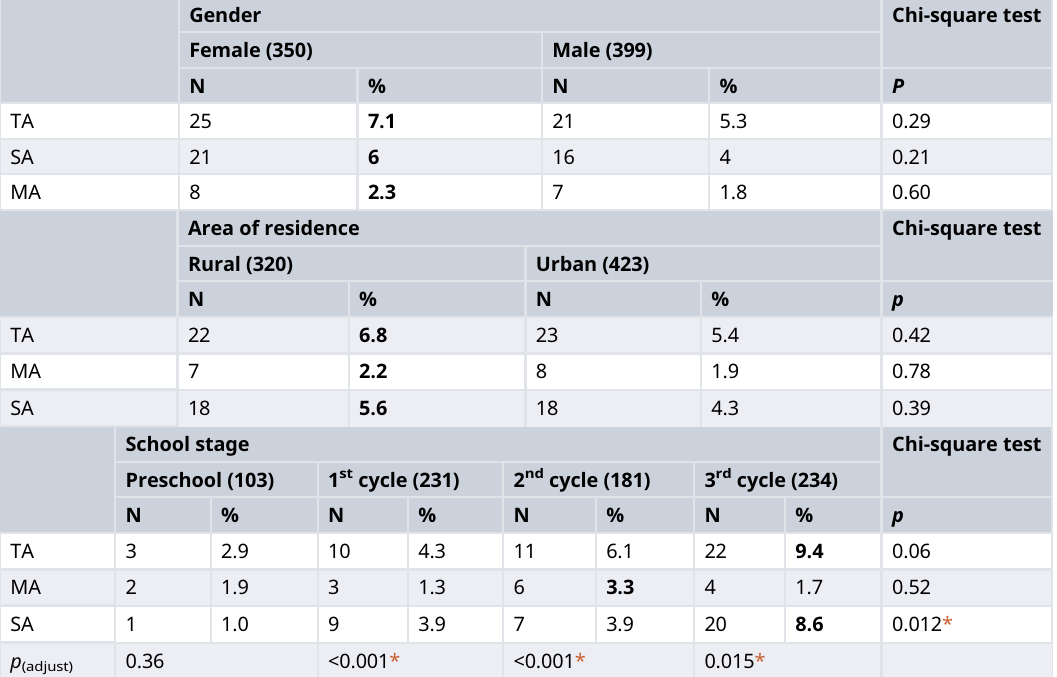
p (adjust) 0.36 <0.001* <0.001* 0.015*